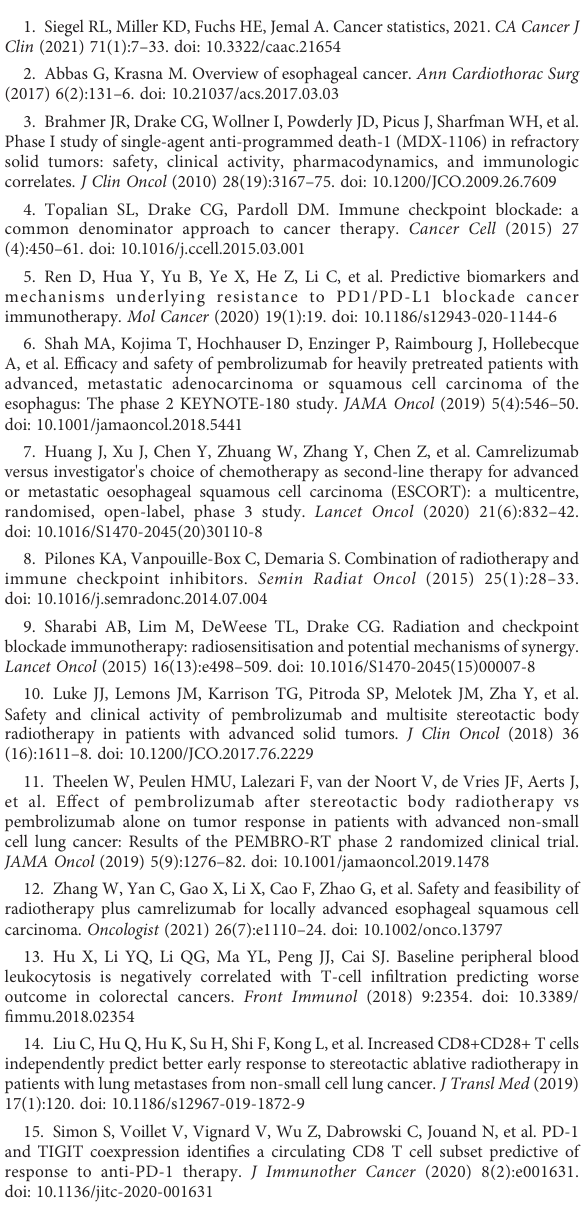
FIGURE S5 Dynamic differentiation status of PD-1+ and PD-1- CD8+ T-cell subsets. (A) PD-1+CD8+ T cells in RT plus immunotherapy group. (B) PD-1-CD8+ T cells in RT plus immunotherapy group. (C) PD-1+CD8+ T cells in CCRT group. (D) PD-1-CD8+ T cells in CCRT